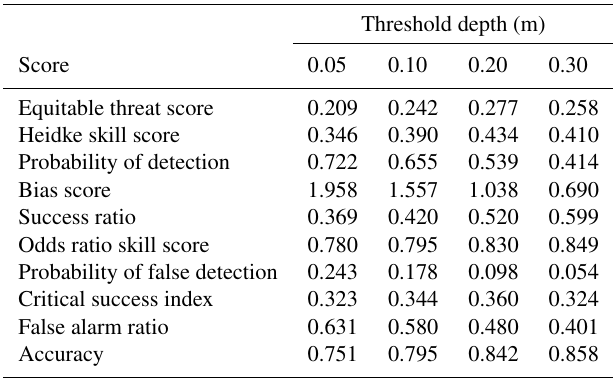
Table 5. Verification of the flood prediction in Hull.